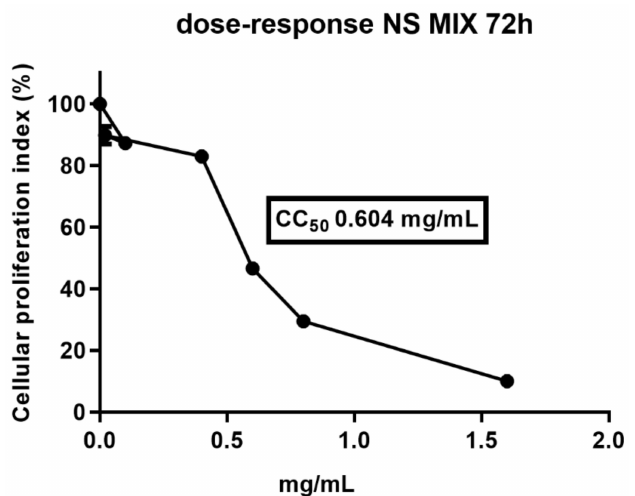
Figure 1. Viability of Vero cells treated with NS MIX. Vero cells were incubated with 1.6, 0.8, 0.6, 0.4, 0.2, and 0.1 mg / mL of NS MIX for 72 h. DMSO was used as a negative control. Cells were